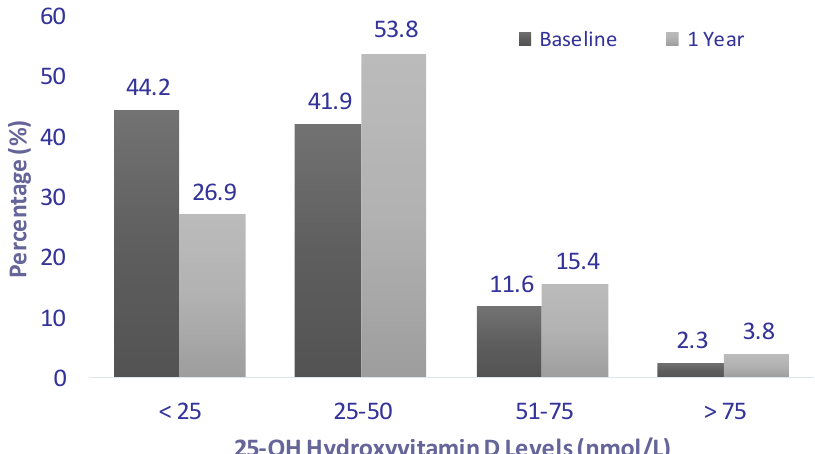
Figure 1. Decreasing prevalence of vitamin D deficiency over the 12-month intervention